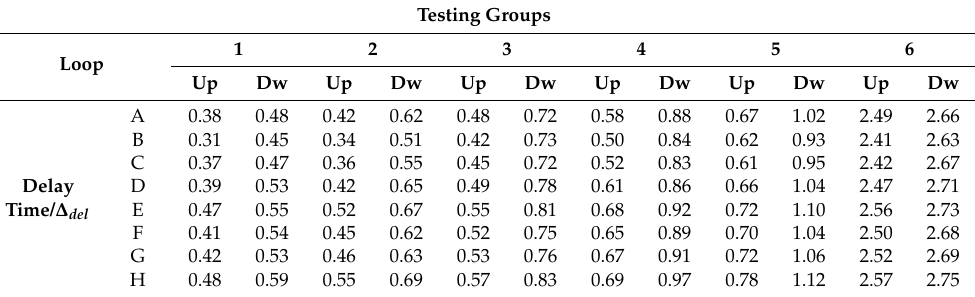
Figure 9. Hysteresis characteristic of PBS under the testing condition of group 1. ( a ) Original data curves; ( b ) Delay time of eight loops in the brake process; ( c ) Delay time of eight loops in the brake release process. Table 3. Delay time of eight loops under the testing condition of all the groups.